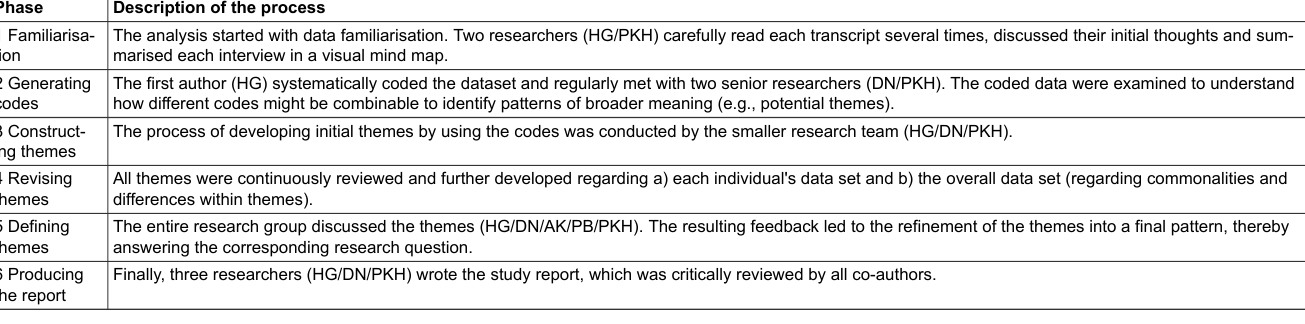
Table 2: Characteristics of